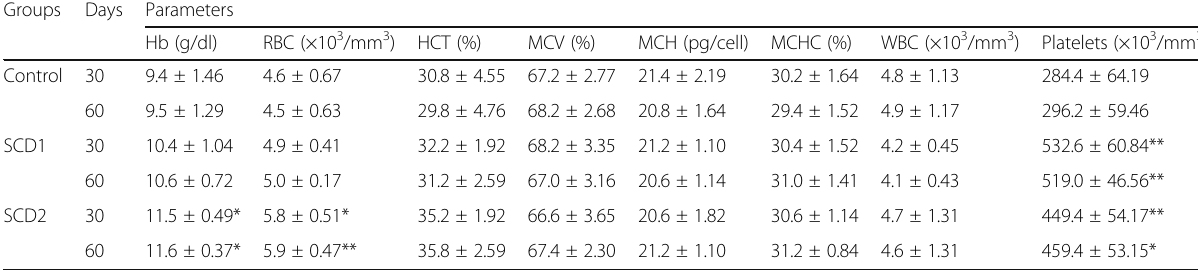
Table 2 In vivo effects of Syzygium cumini leaves extract and control on rabbit ’ s hematological parameters Groups Days Parameters